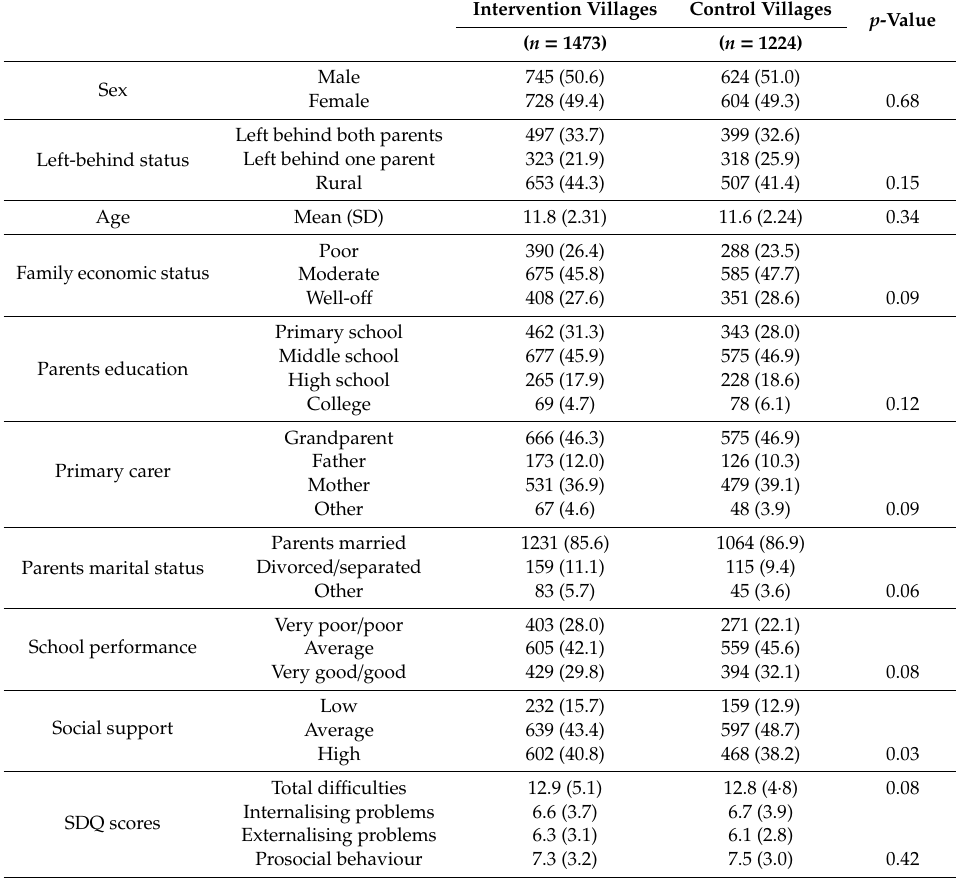
Table 1. Baseline characteristics of children in intervention and control villages.